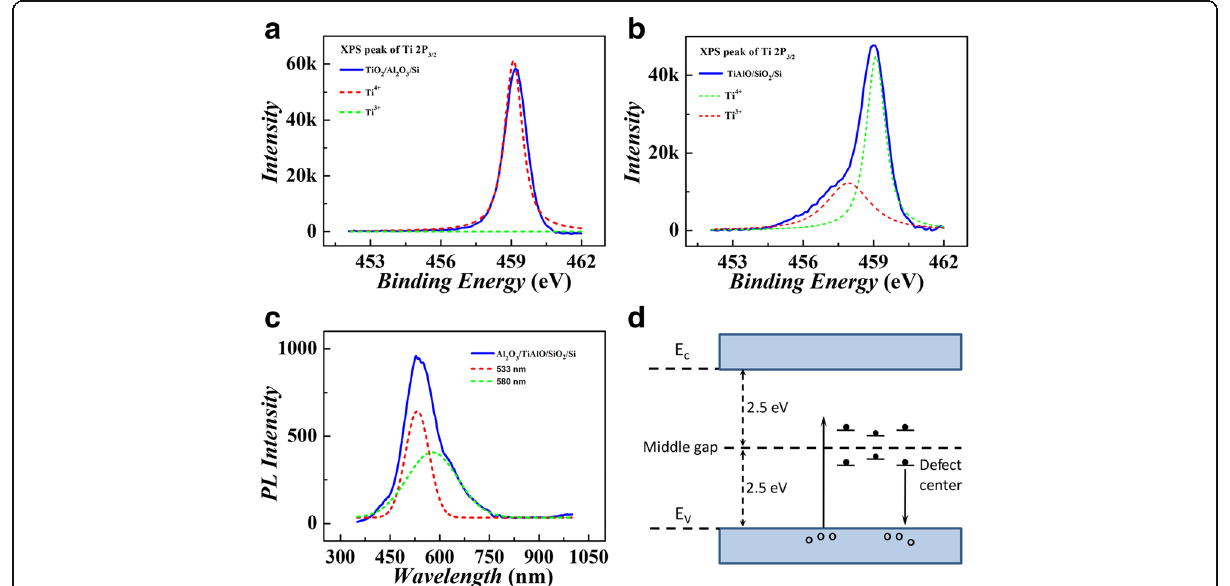
Fig. 5 ( Color online ) XPS spectra of Ti 2p 3/2 states from the TiO 2 /Al 2 O 3 /Si ( a ) and TiAlO/SiO 2 /Si ( b ) structure. c Room-temperature PL spectra from Al 2 O 3 /TiAlO/SiO 2 structure. d A schematic diagram of the defect levels and PL processes in TiAlO